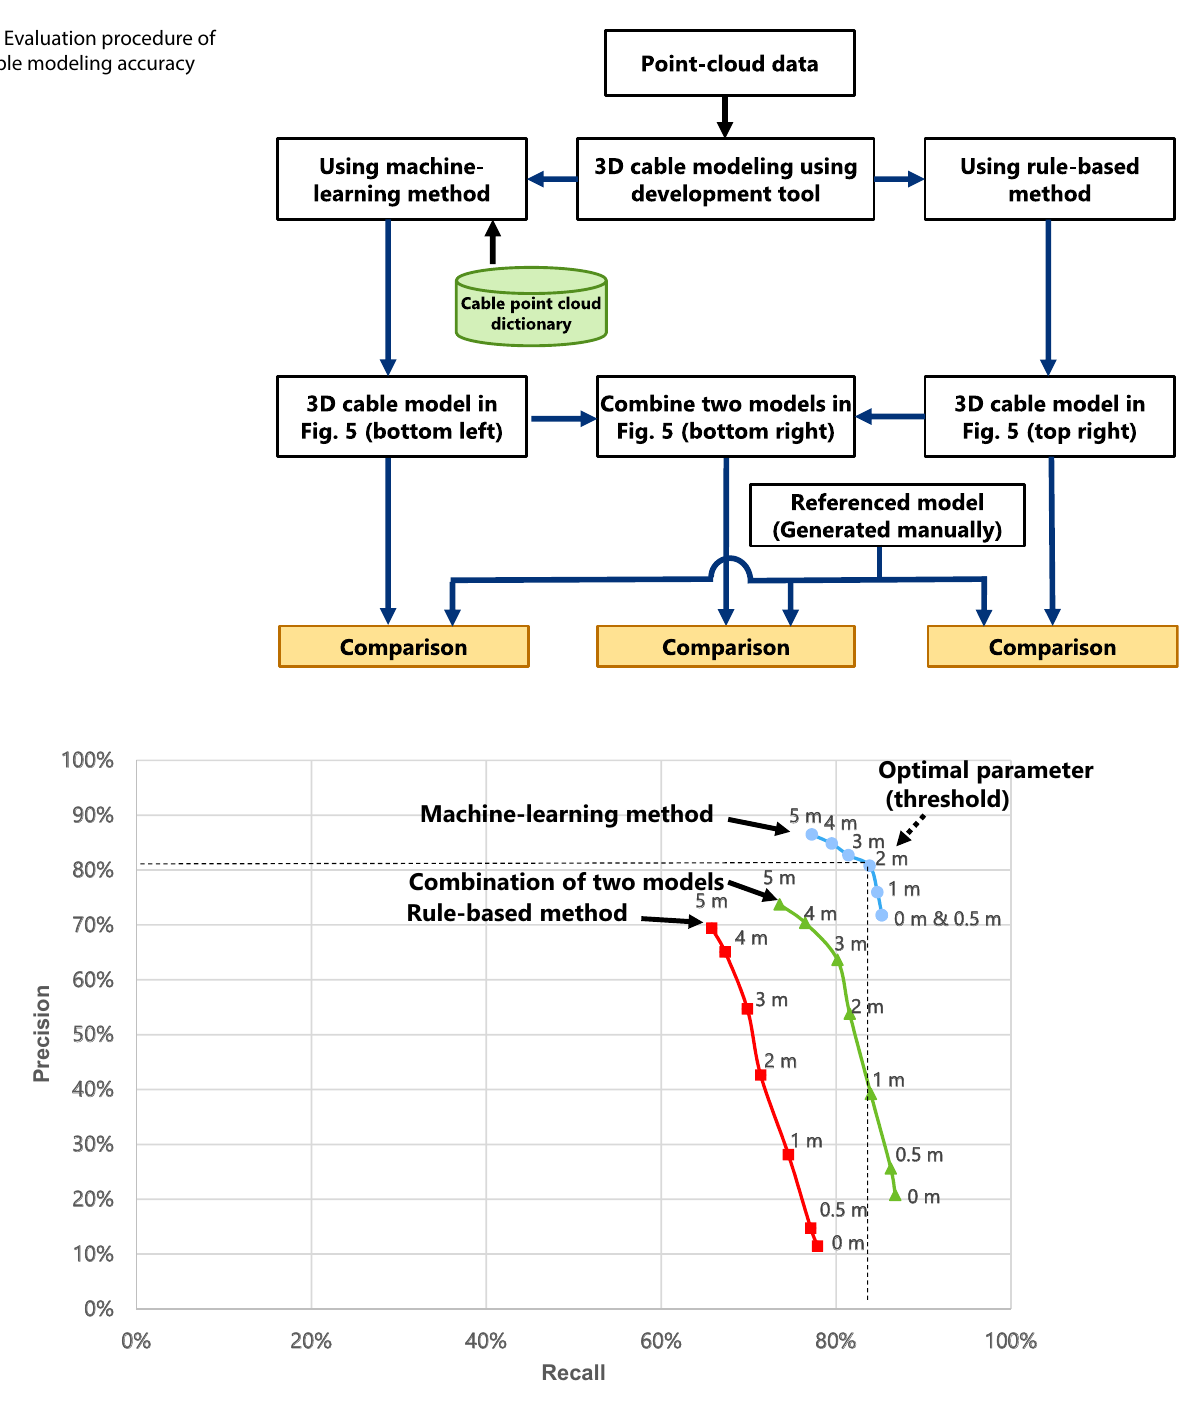
Fig. 7 PR curves. Precision level for 0 and 0.5 m with machine learning is the